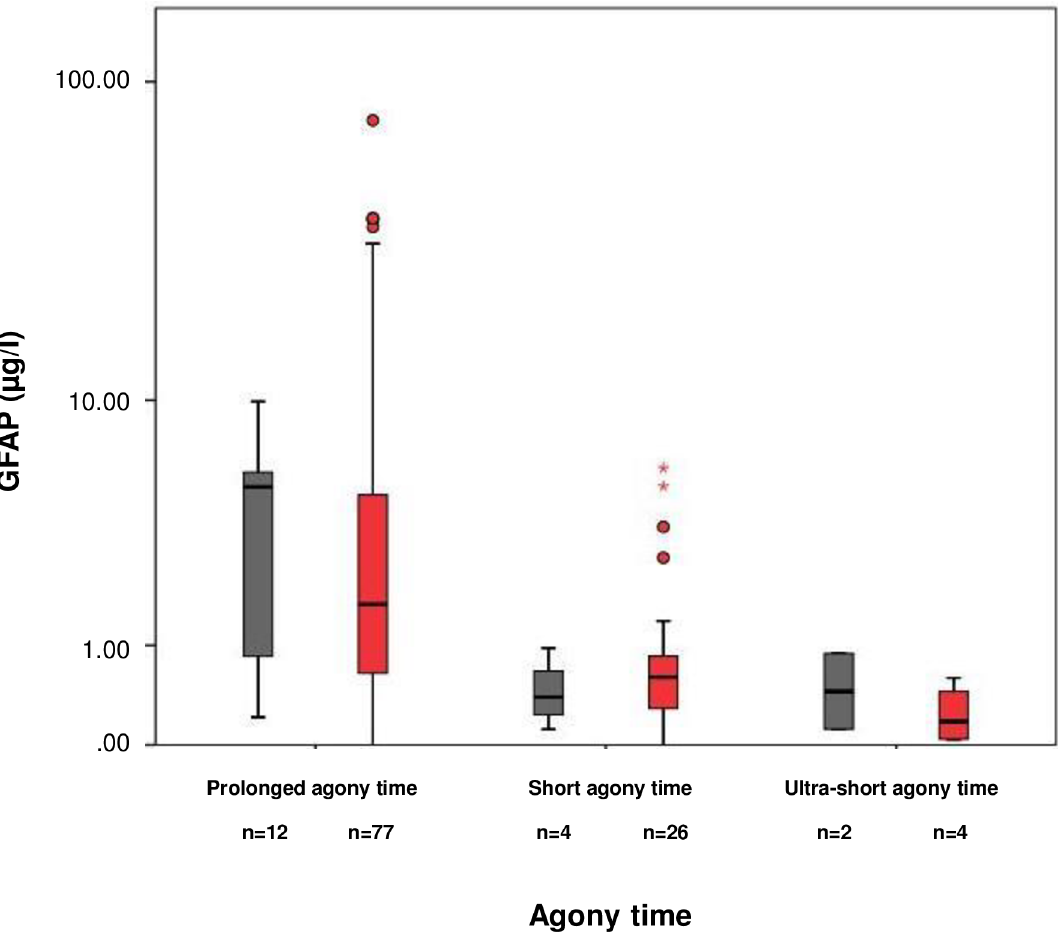
Fig 2. Post-mortem GFAP serum concentrations of the primary cerebral and the primary non-cerebral cause of death group stratified according to agony time. GFAP concentrations of the cerebral cause of death group (grey bars): ultra-short agony times (median 0.53 μg/l [minimum 0.12, maximum 0.89]; n = 2), short agony times (0.39 μg/l [IQR 0.65, 0.12, 0.96]; n = 4), and prolonged agony times (5.02 μg/l [5.26, 0.21, 9.91], n = 12; Kruskal Wallis p = 0.003; post-hoc ultra-short versus prolonged agony times p = 0.051, short versus prolonged agony p = 0.043). GFAP concentrations of the non-cerebral cause of death group (red bars): ultra-short agony times (median 0.19 μg/l [IQR 0.49 minimum 0.03, maximum 0.59]; n = 4), short agony times (0.60 μg/l [0.57, 0.00, 5.87]; n = 26), and prolonged agony times (1.66 μg/l [4.21, 0.28, 76.25], n = 77; Kruskal Wallis p < 0.001; post-hoc ultra-short versus prolonged agony times p = 0.009, short versus prolonged agony p < 0.001).